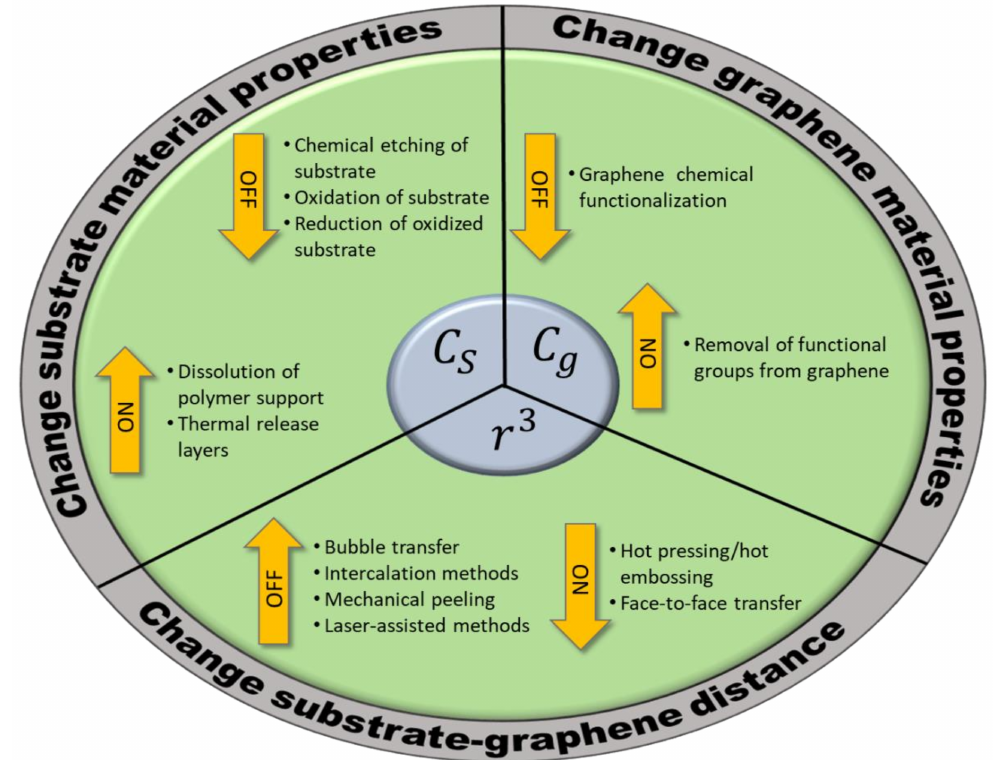
Figure 3. Graphical representation of different graphene transfer methods and the mechanisms by which they modulate the interaction between graphene and substrate. The central circle depicts the three variables which govern the graphene- substrate adhesion energy, and by changing each of the variables, one may promote either delamination (denoted “OFF”) or relamination (denoted “ON”) of the graphene on a